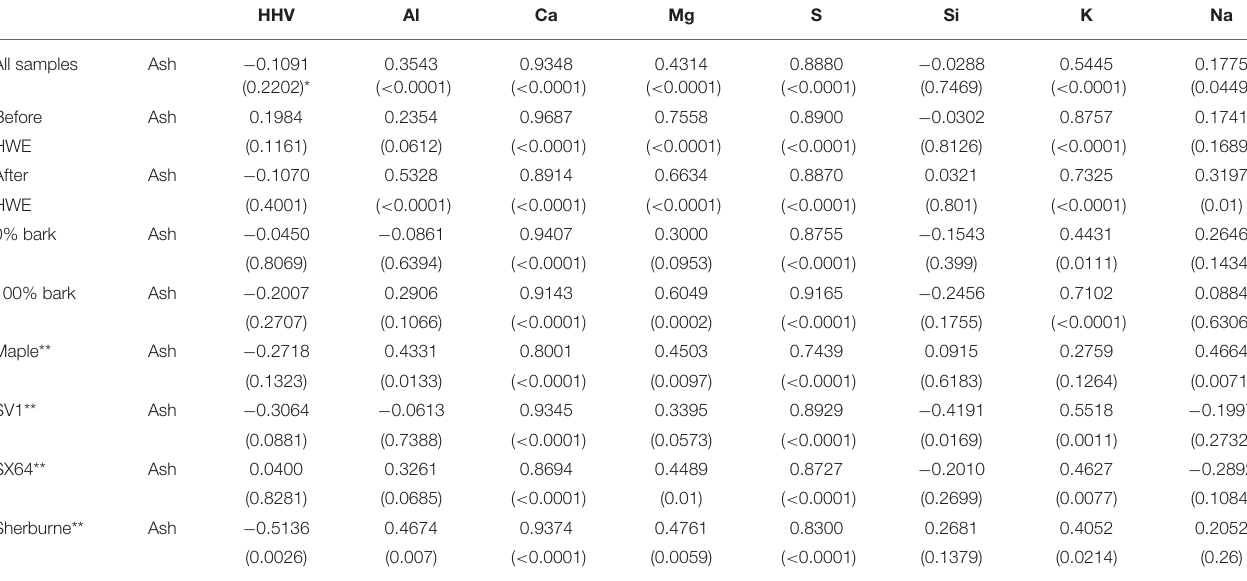
TABLE 4 | Pearson correlation coefficients and P-values for ash, heating value and various elements.